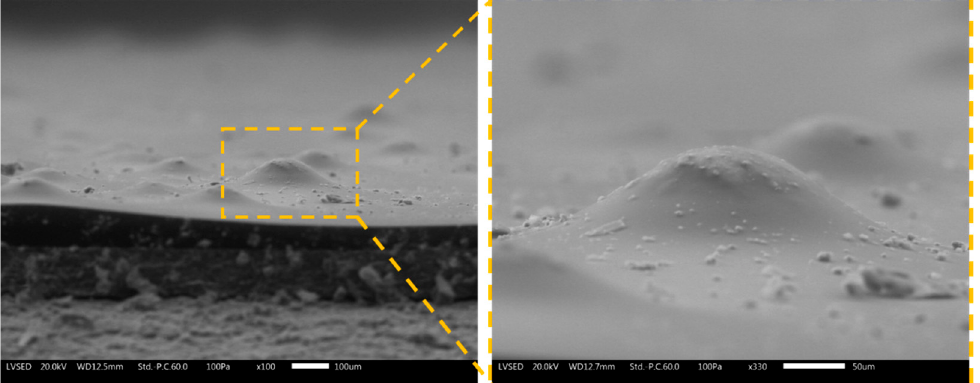
Figure 4. SEM micrograph of the cross-section of coating G3, focusing on the surface roughness due to the glass spheres.